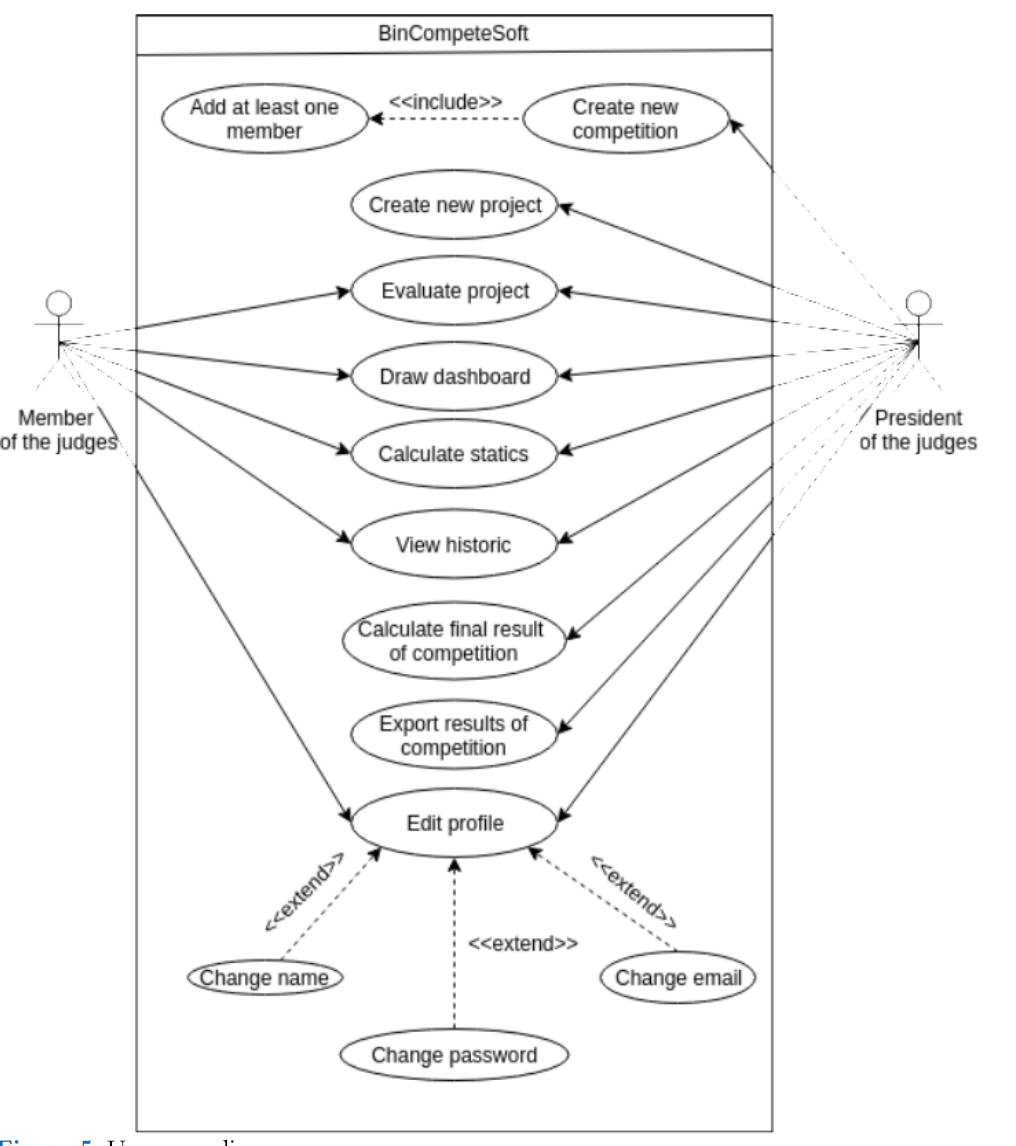
Figure 5. Use cases